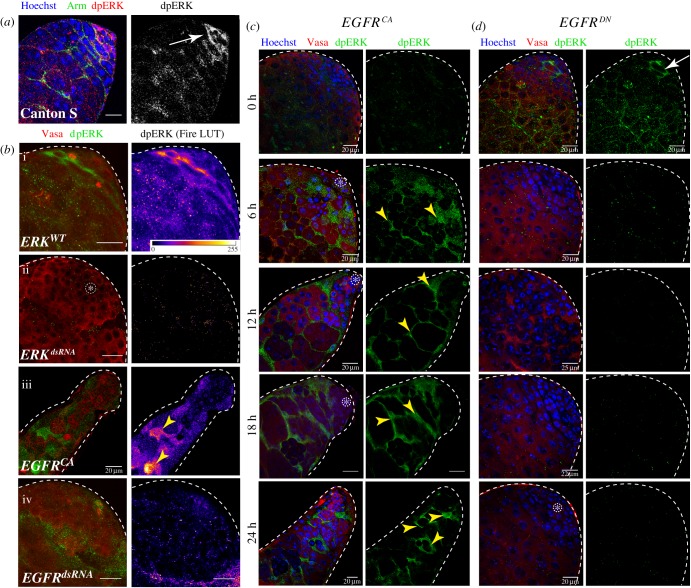
Correlation of somatic ERK phosphorylation with EGFR activation and downregulation. Adult testes from different genotypic backgrounds as indicated in the panels were stained with anti-Arm (green), anti-dpERK (red) and the Hoechst (blue) dye (a), or, anti-dpERK (green), anti-Vasa (red) and Hoechst (magenta) dye (b–d). The UAS-transgenes indicated on the panels were expressed in the SCCs either by using tjGal4 (b), or tjGal4 along with tub-Gal80ts (c,d). In the latter case, the expression level was progressively elevated by growing the stocks at 29°C for different extents as indicated on the left margin of panel (c). The images depicting anti-dpERK staining in panels (b) and (c) were thresholded to the 95% intensity values to highlight the peak staining for an effective visual comparison. Arrowheads indicate intense cytoplasmic anti-dpERK staining in the SCCs. Scale bars measure 20 µm.